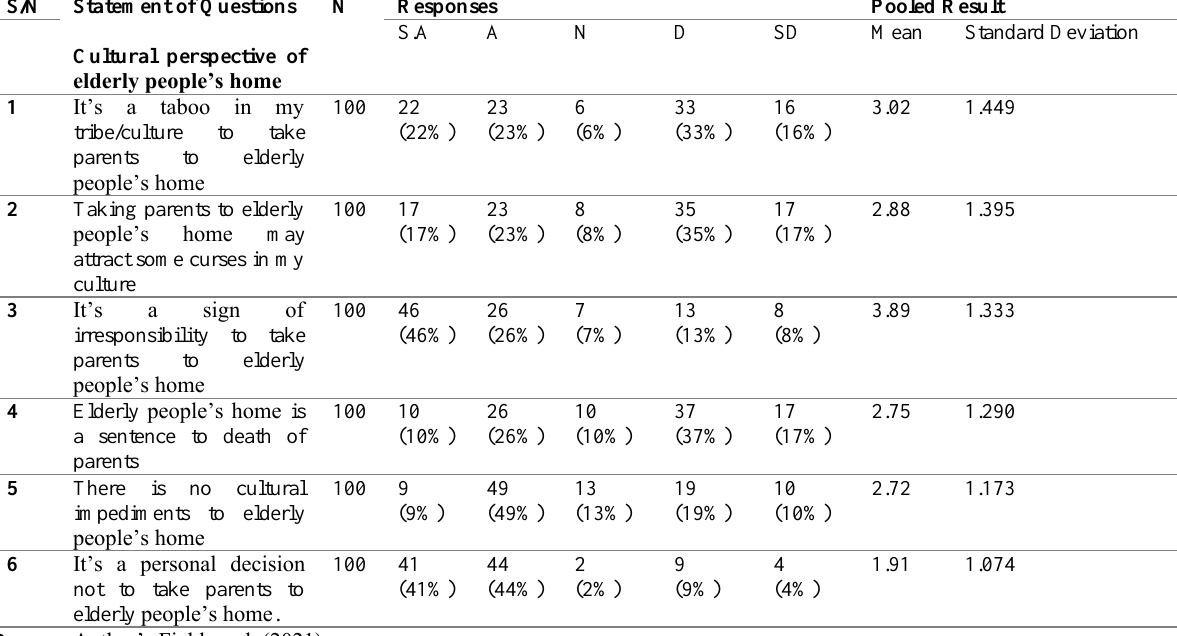
Table 3: Cultural perspective of elderly people’s